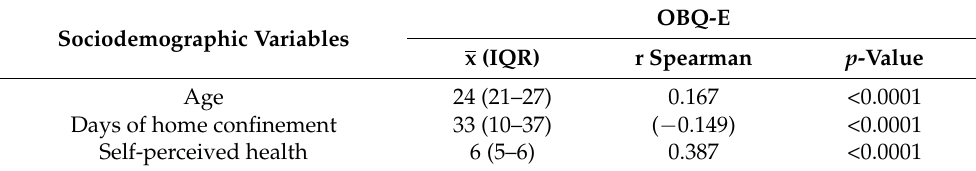
Table 2. Correlation between OBQ-E scores and continuous variables.